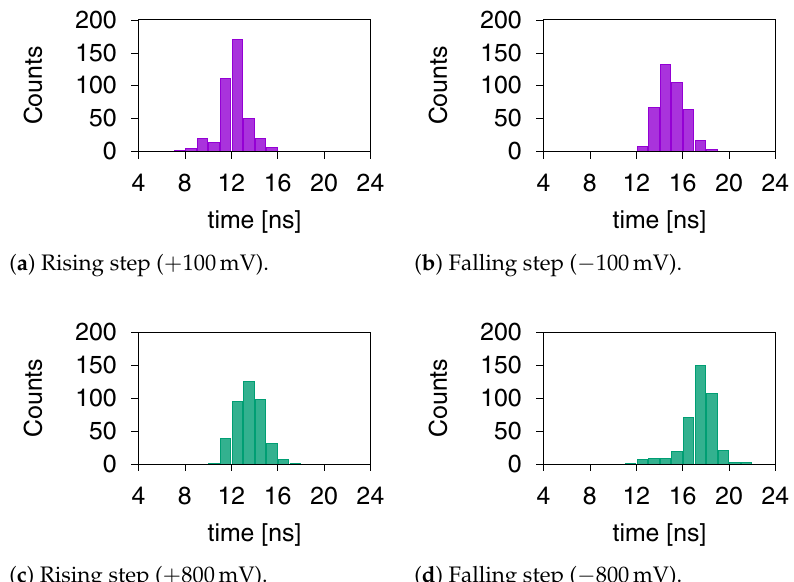
under both global and local process variations. The results are condensed in the histograms